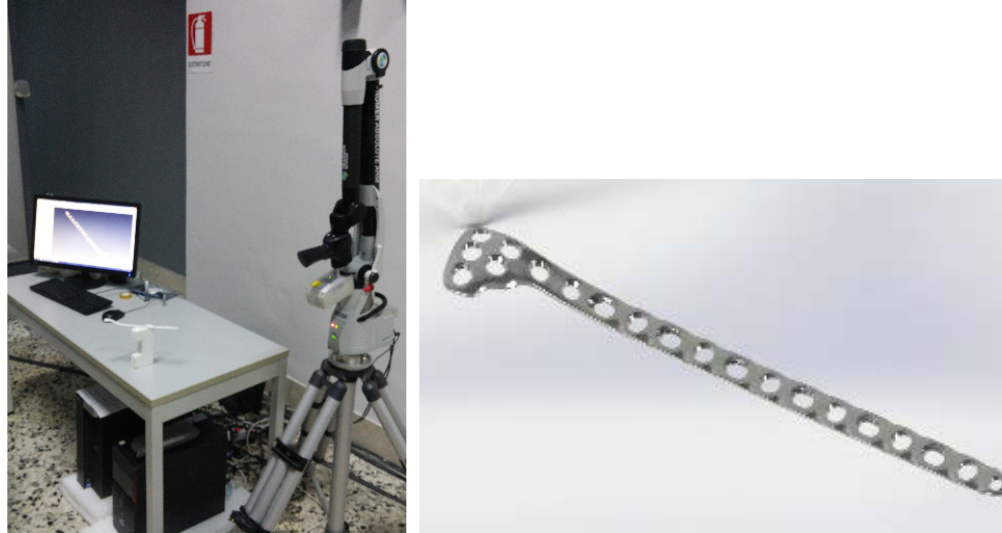
Figure 3. Hexagon metrology 3D laser scanner HP-L-20.8 (left) and reconstructed CAD model of the plate (right).